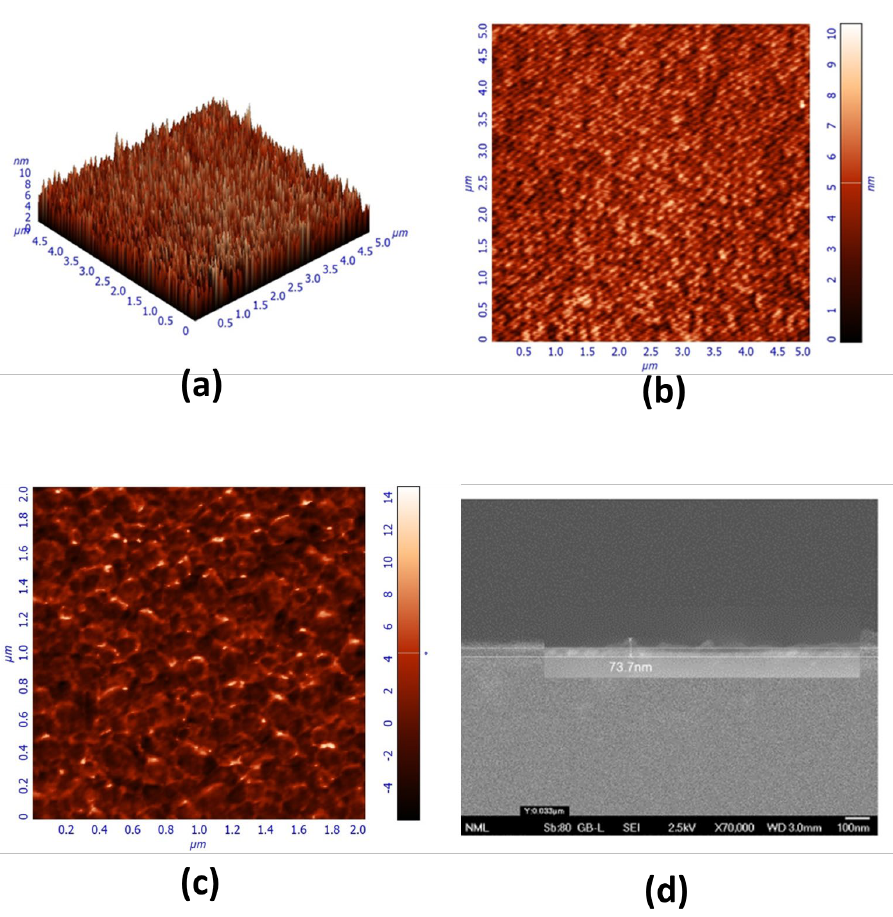
Figure 9. ( a ) The AFM of the side view, ( b , c ) the AFM from the top view from different scales and ( d ) the cross section of the undoped sample.